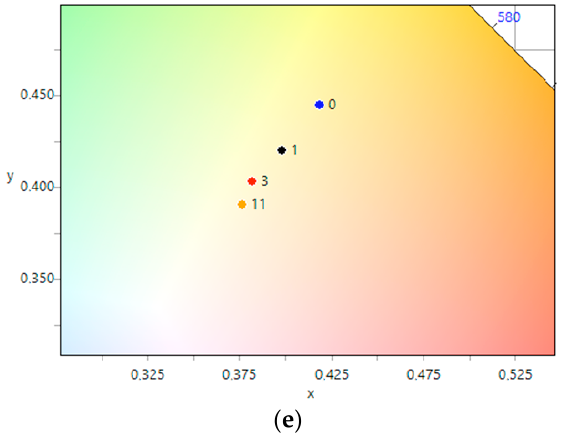
Figure 8. Change of color coordinates in the CIE 1931 coordinate system during the photodegradation of methyl orange: ( a ) CeO 2 , ( b ) CeO 2 -Ag1, ( c ) CeO 2 -Ag2, ( d ) CeO 2 -Ag3, ( e ) CeO 2 -Ag4.